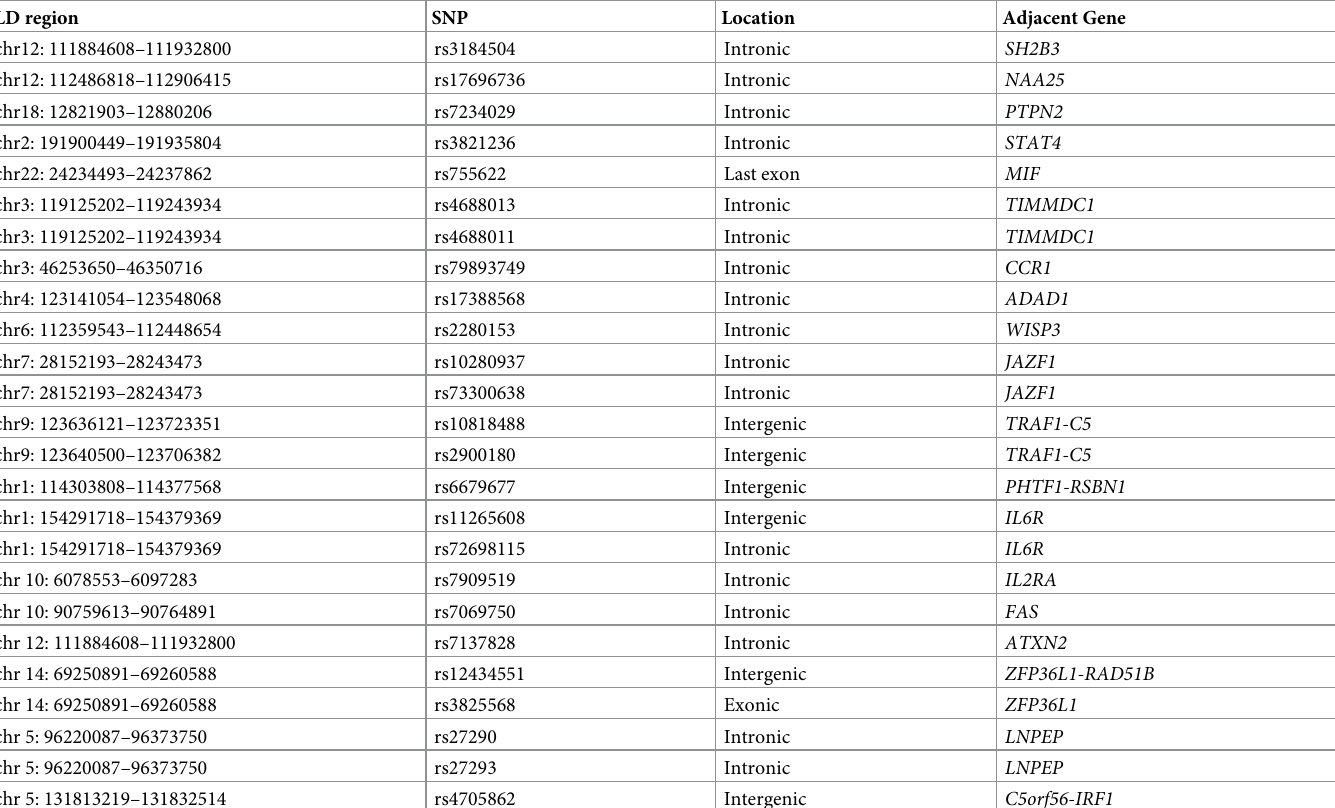
Table 1. JIA risk haplotypes queried In HiC analyses. LD